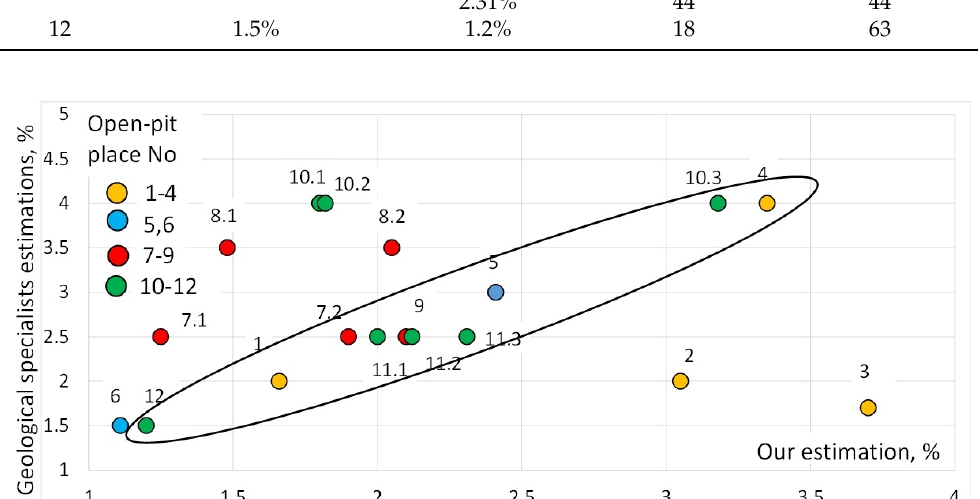
Figure 13. Relation of our and experts estimated asbestos content values (in correspondence